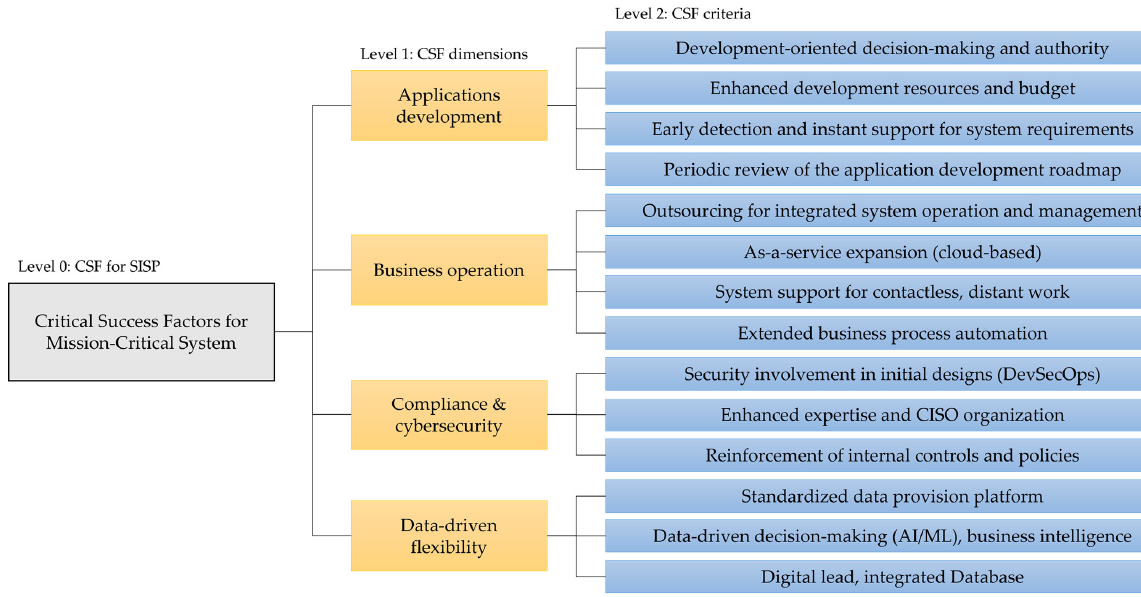
Figure 3. Critical success factors hierarchy.